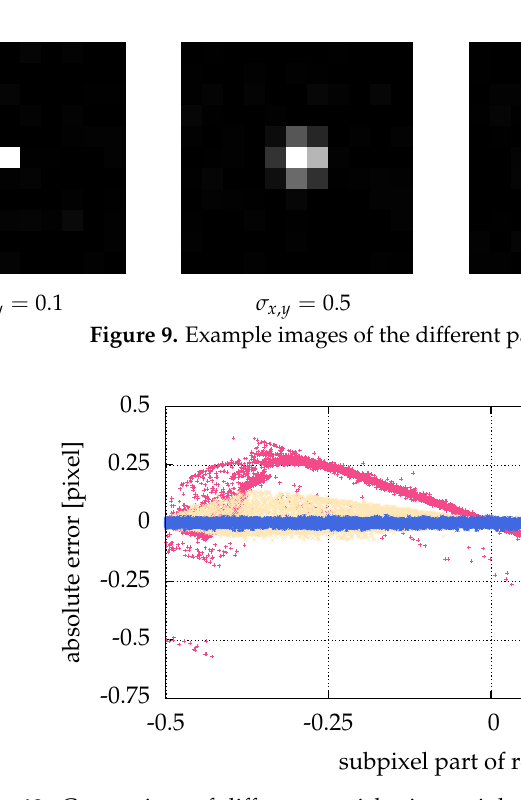
Figure 10. Comparison of different particle sizes: pink ( (cid:4) ) points for σ { x , y } = 0.1, yellow ( (cid:4) ) for σ { x , y } = 0.5 and blue ( (cid:4) ) for σ { x , y } = 1. For σ { x , y } = 2, the same visual result was obtained as for σ { x , y } = 1. There was a low Gaussian noise added, with a SNR = 100, and no salt and pepper noise. The statistic/simulation was done with images containing 10,000 particles. The abscissa shows the sub-pixel coordinate of the real positions, whereas the ordinate shows the respective absolute error of the positions calculated with